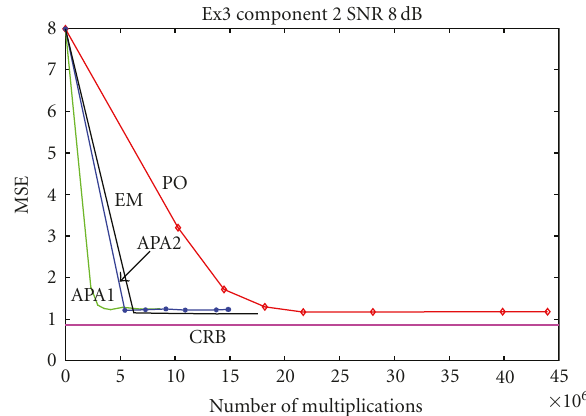
Figure 12: Experimental MSE versus computation cost for Ex3 at 8dB (component